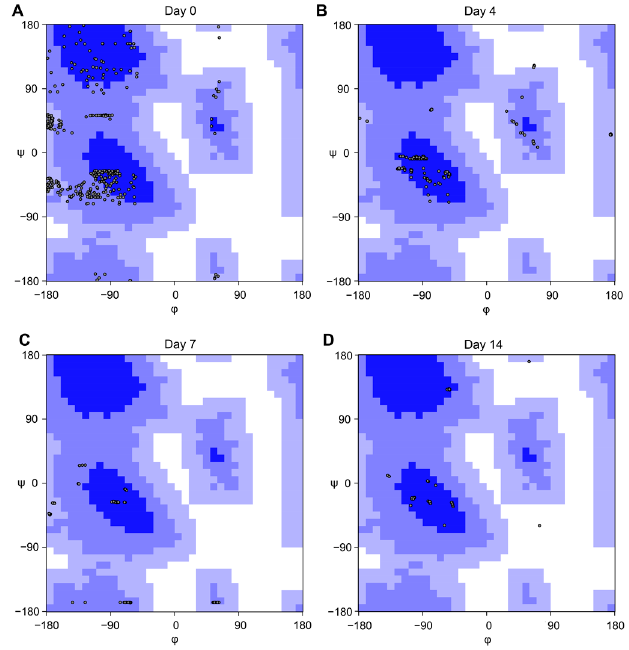
Figure 3. Ramachandran plot of A β (25 − 35) peptide at ( A ) day 0, ( B ) day 4, ( C ) day 7, and ( D ) day 14 in SDS micelles.